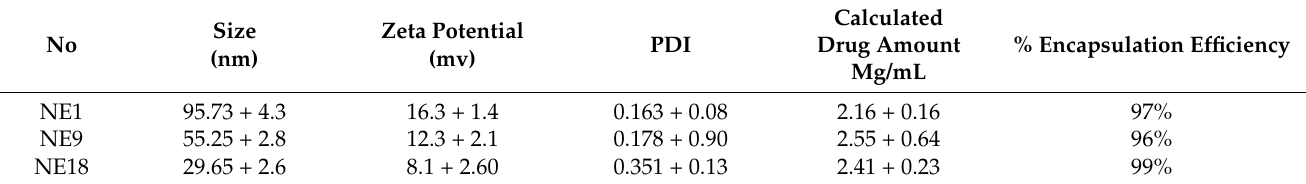
Table 4. Analysis of particle size, PDI, ZP, and percentage drug load of the optimised NE formulations. The results represent mean ± SD ( n =